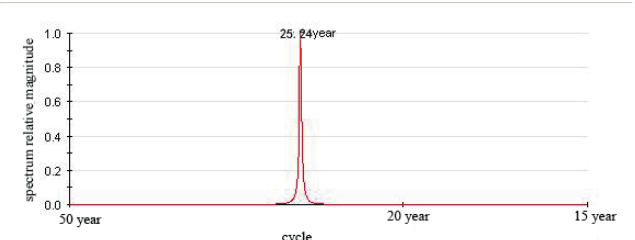
Fig. 3 The entropy spectrum of Xi’an station on the 20−50a